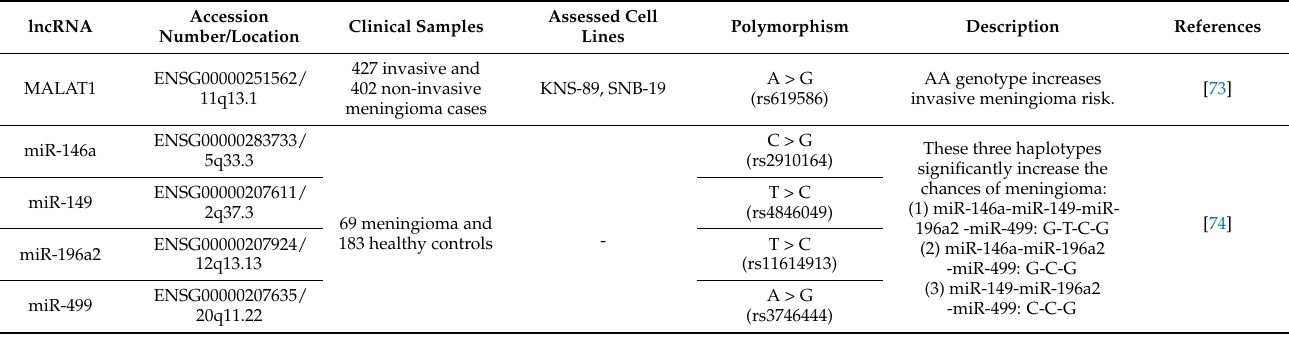
Table 7. Polymorphisms of non-coding RNAs in